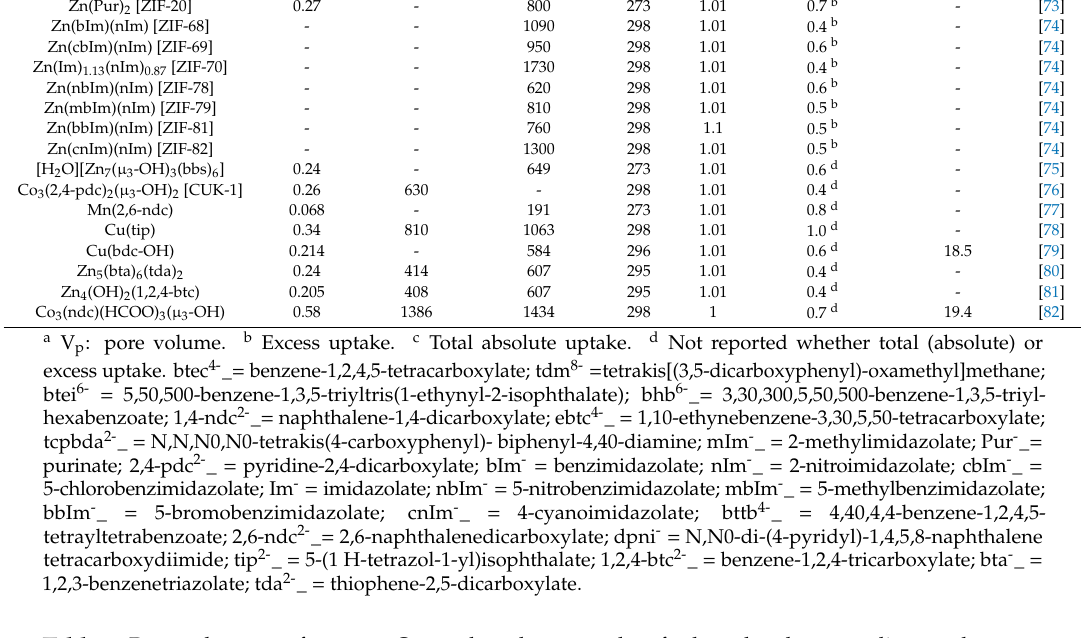
Table 2. Pore volume, surface area, Q st , and methane uptake of selected carbons, zeolites, and porous organic